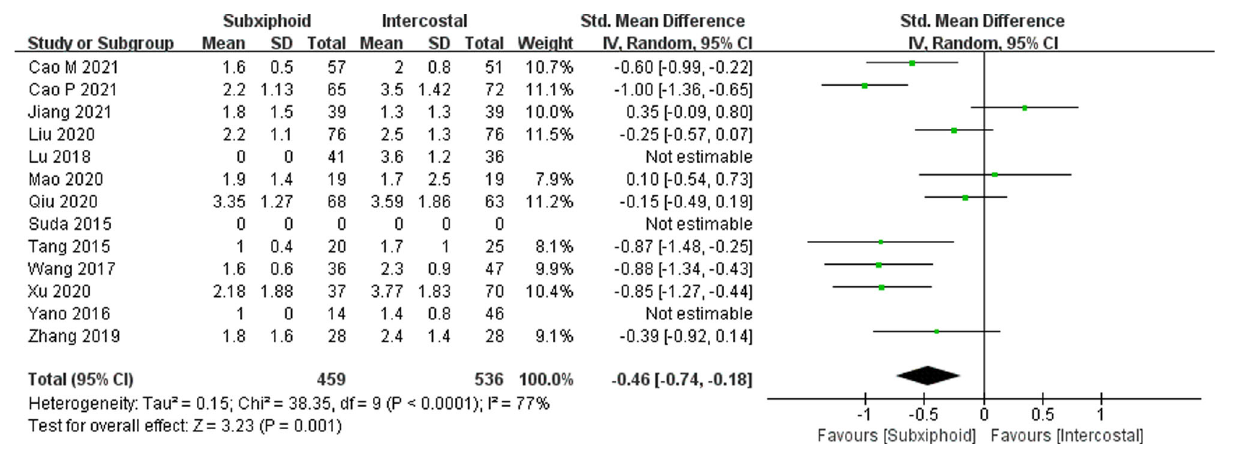
FIGURE 7 | Forest plot of the role of SMD and its 95% CI of postoperative drainage days between SVATS and IVATS groups.